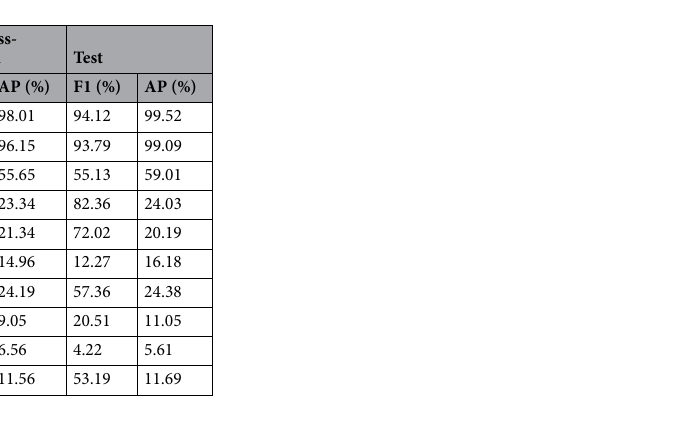
Table 3. Hierarchical classification. F1 F1-score, AP average